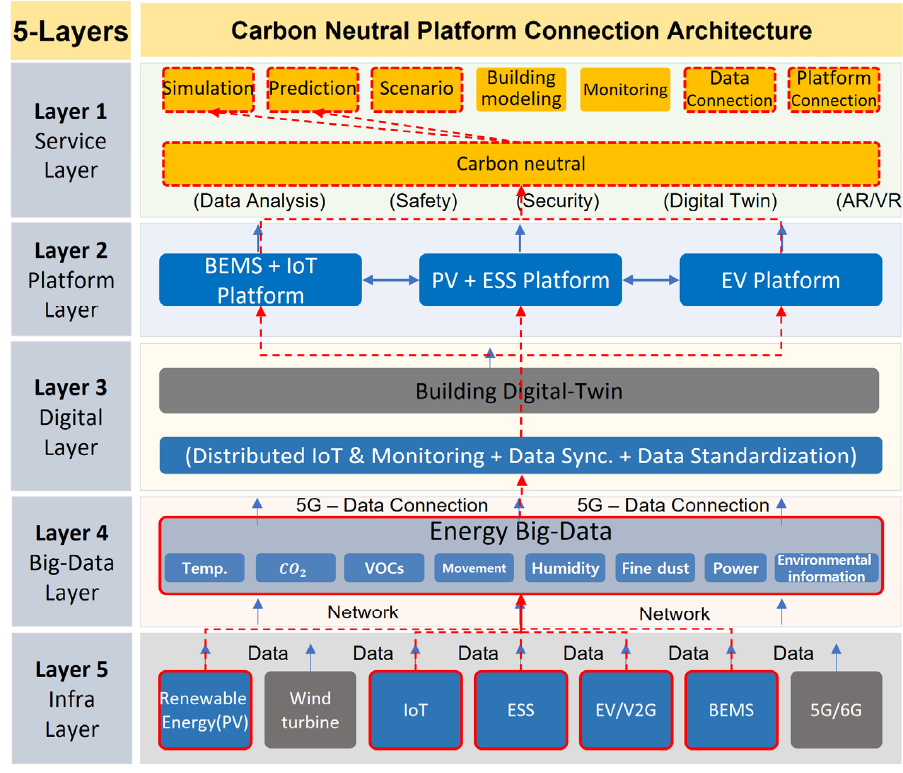
Figure 3. Carbon-neutral digital innovation platform